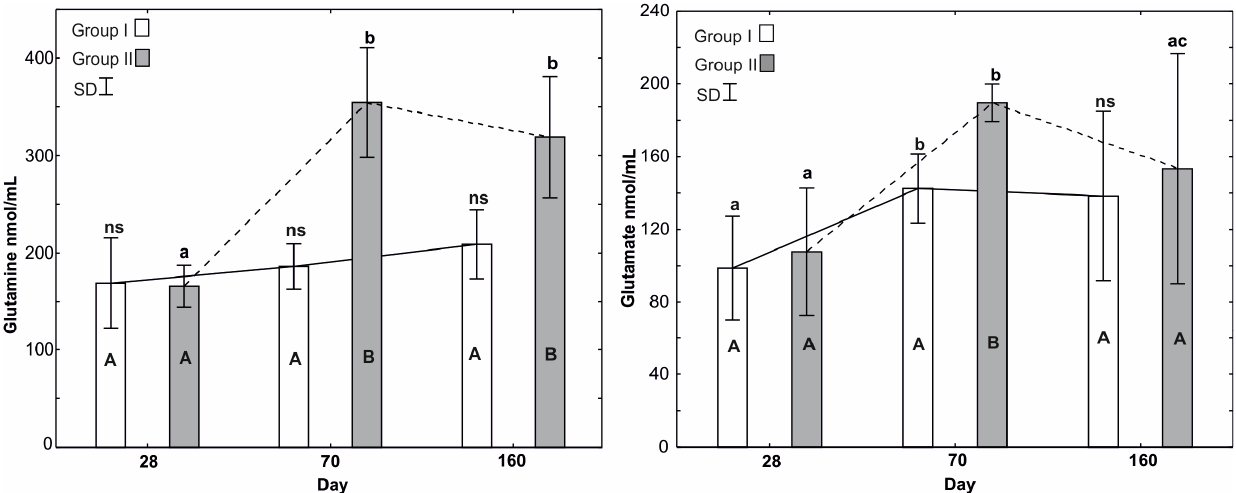
Figure 4. Glutamine and glutamate concentrations (nmol/mL) in the peripheral blood of pigs. Values are expressed as mean and standard deviation ( α ± SD). One-way ANOVA followed by Friedman’s between the control and experimental groups. Capital le tt ers indicate statistically signi fi cant results